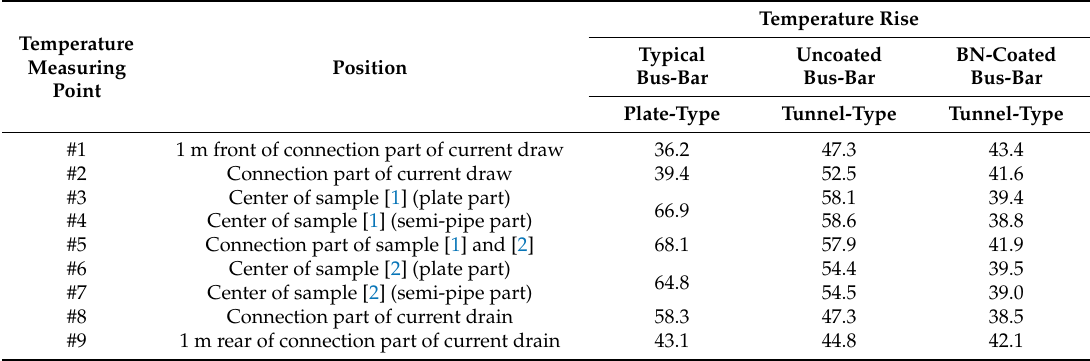
Figure 12. Schematic of the experiment using actual-size two tunnel-type bus-bars and the position of the temperature measuring point. Table 5. Temperature rise values of plate-type, uncoated and BN-coated bus-bars.